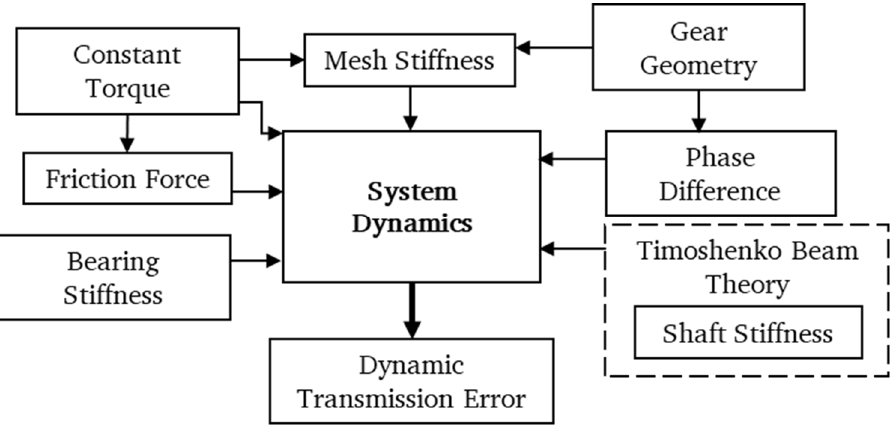
Figure 3. Flow chart for dynamic transmission error calculation.